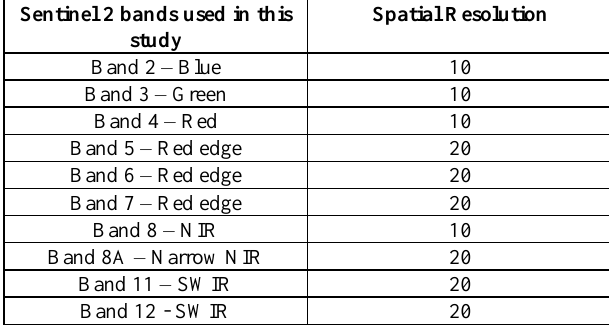
Table1. Sentinel 2 bands used in this